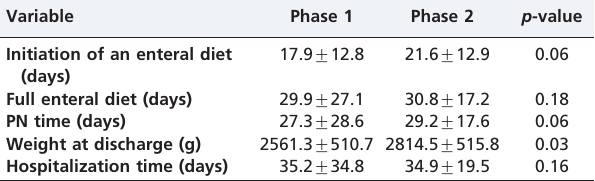
Table 4 - Initiation time for an enteral diet or a full diet, length of time for parenteral nutrition, weight at discharge, and hospitalization time in the two phases of the study (mean ¡